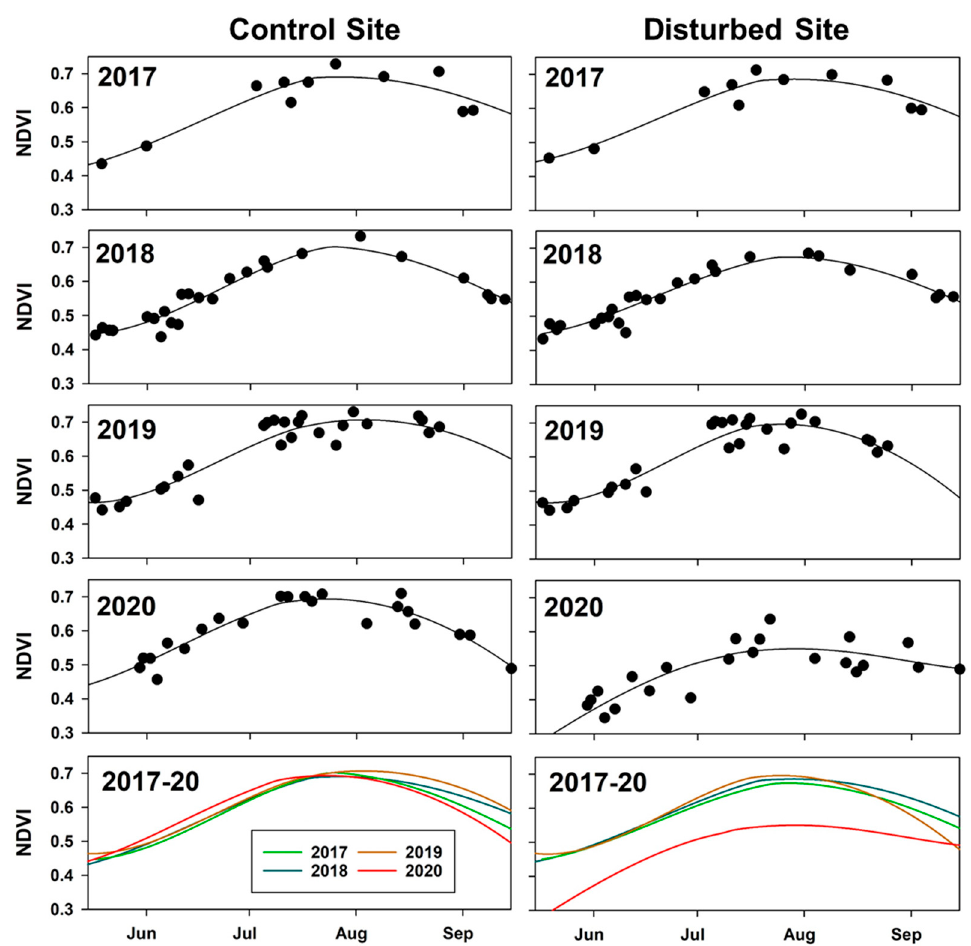
Figure 8. NDVI data derived from a time series of Sentinel-2 satellite imagery acquired between 2017 and 2020 for a control site and a site within the beaver-induced permafrost degradation feature area. The black dots indicate single-pixel, individual NDVI values from a particular Sentinel-2 image, while the black curves represent the time integrated NDVI value for each site for each year based on LOESS smoothing using a 3rd order polynomial. The beaver induced permafrost degradation feature is evident in the rapid decline in NDVI that started in August 2019 and also reflected in the reduction in NDVI values during the entire 2020 growing season.